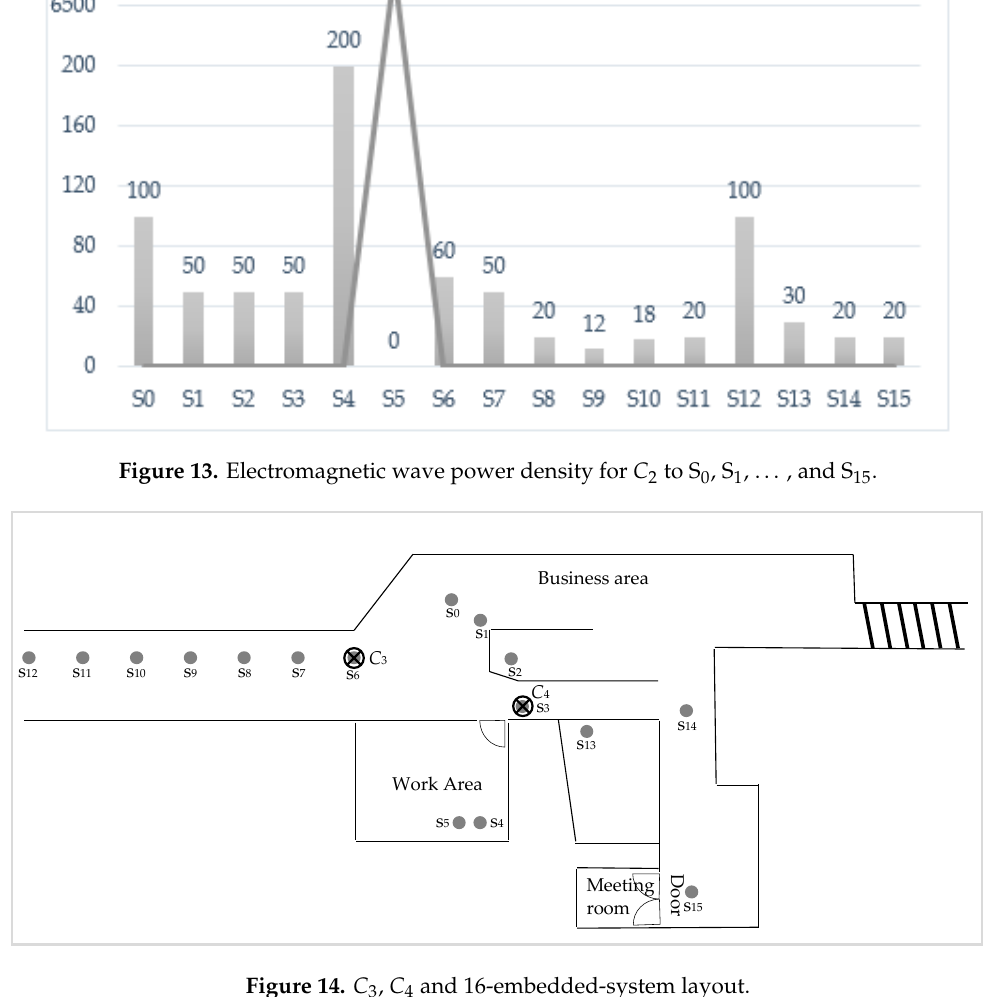
Figure 14. C 3 , C 4 and 16-embedded-system layout.